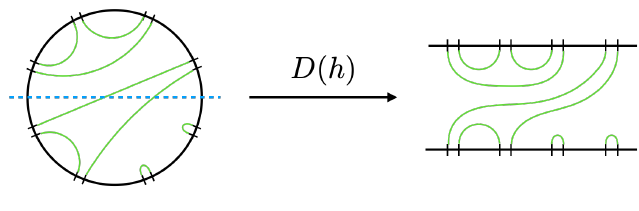
to D ( h ) ∈ TL can be m m